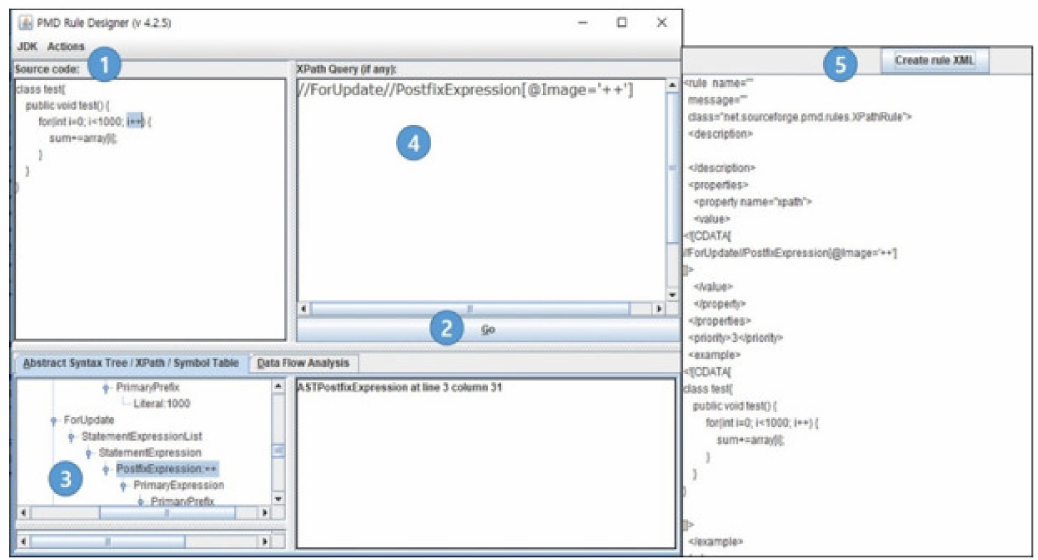
Figure 5. XPath extraction method using the PMD rule